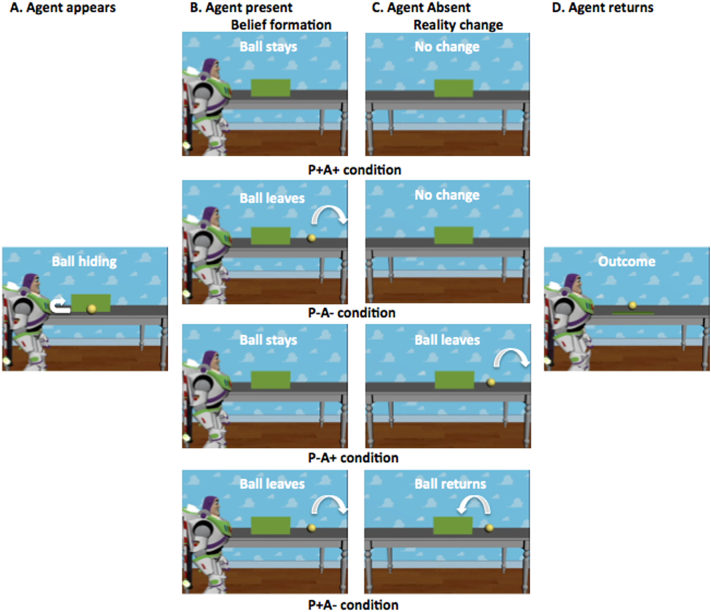
Schematic illustration of the eight different conditions, resulting from four different options in the belief formation phase (middle two columns: P+A+, P-A-, P-A+, P+A-) and two options in the outcome phase (right column: B-, B+), of which one (B+) is depicted here.